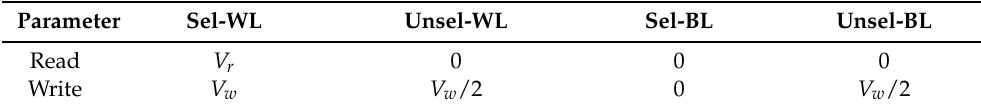
Table 1. Read and write voltage